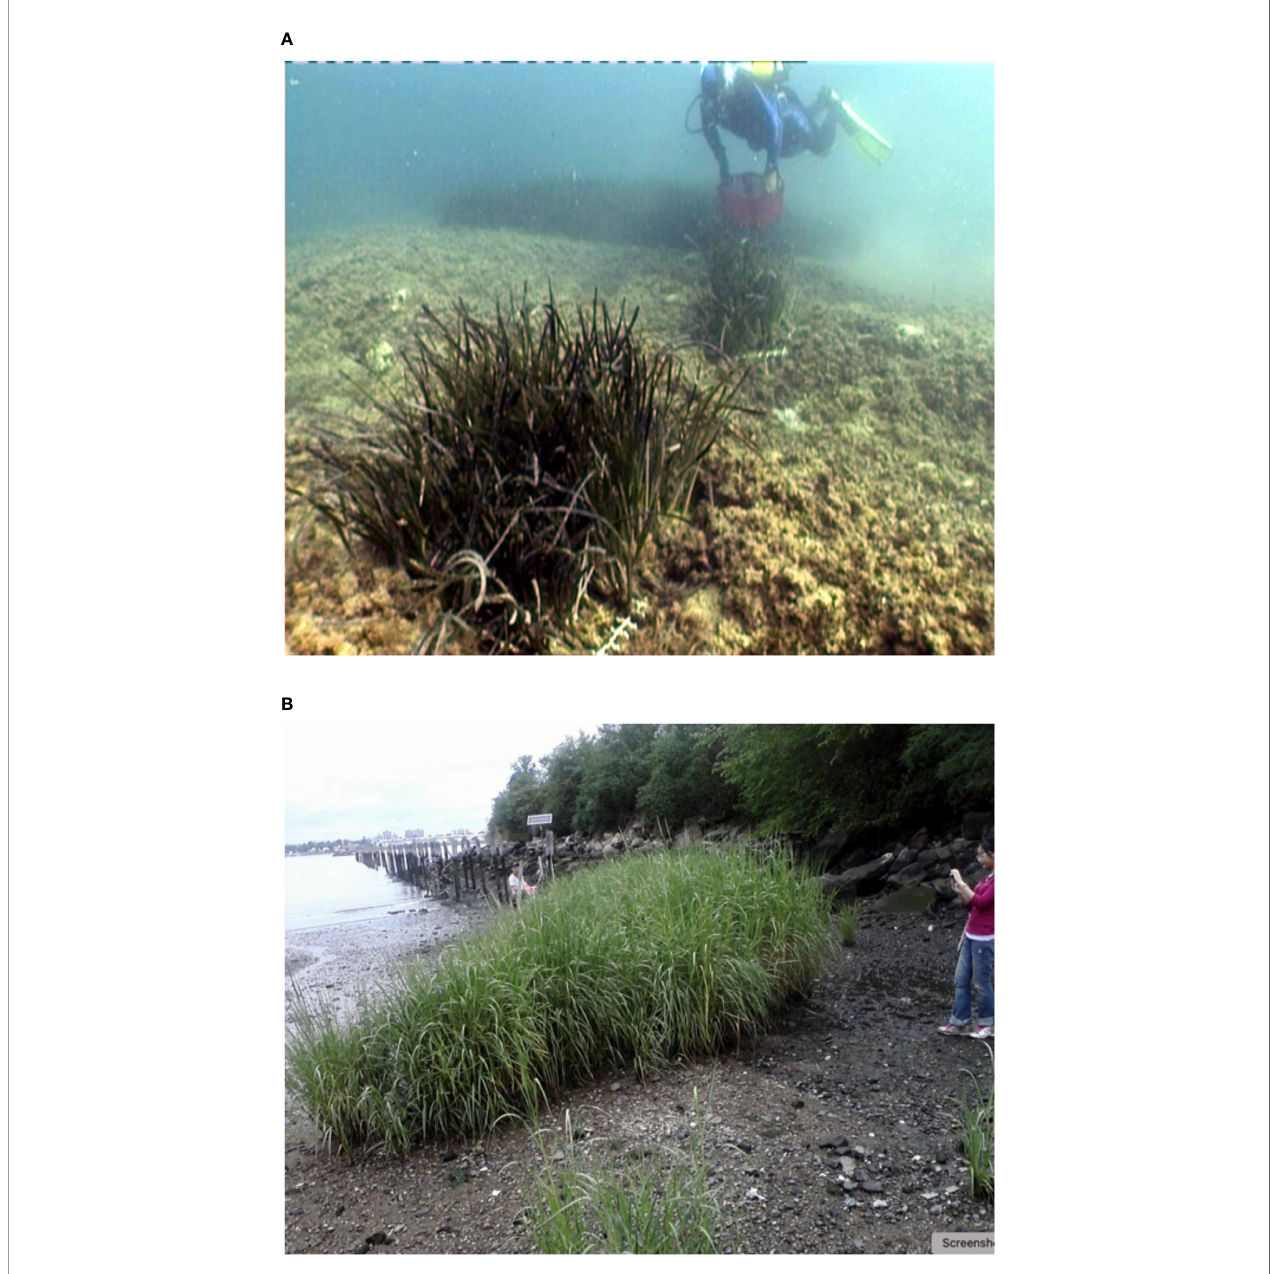
FIGURE 15 | (A) Two patches of Biorock seagrass growth on limestone bedrock in the Adriatic Sea, Italy. Controls all died. Photograph by Raffaele Vaccarella. (B) Saltmarsh grass grows higher and spreads underground, powered by a solar panel. Biorock salt marsh grass at right, controls at left and in front. Biorock salt marsh survives winters and expands seaward, while controls die and wash away. College Point, New York City, photograph by James